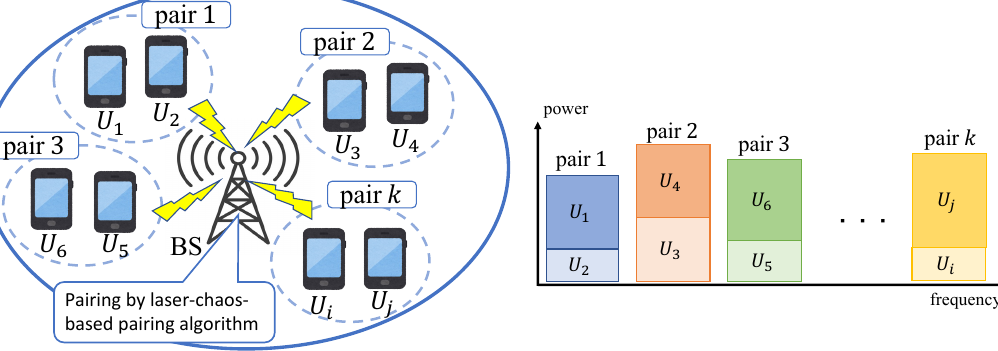
Figure 1. System